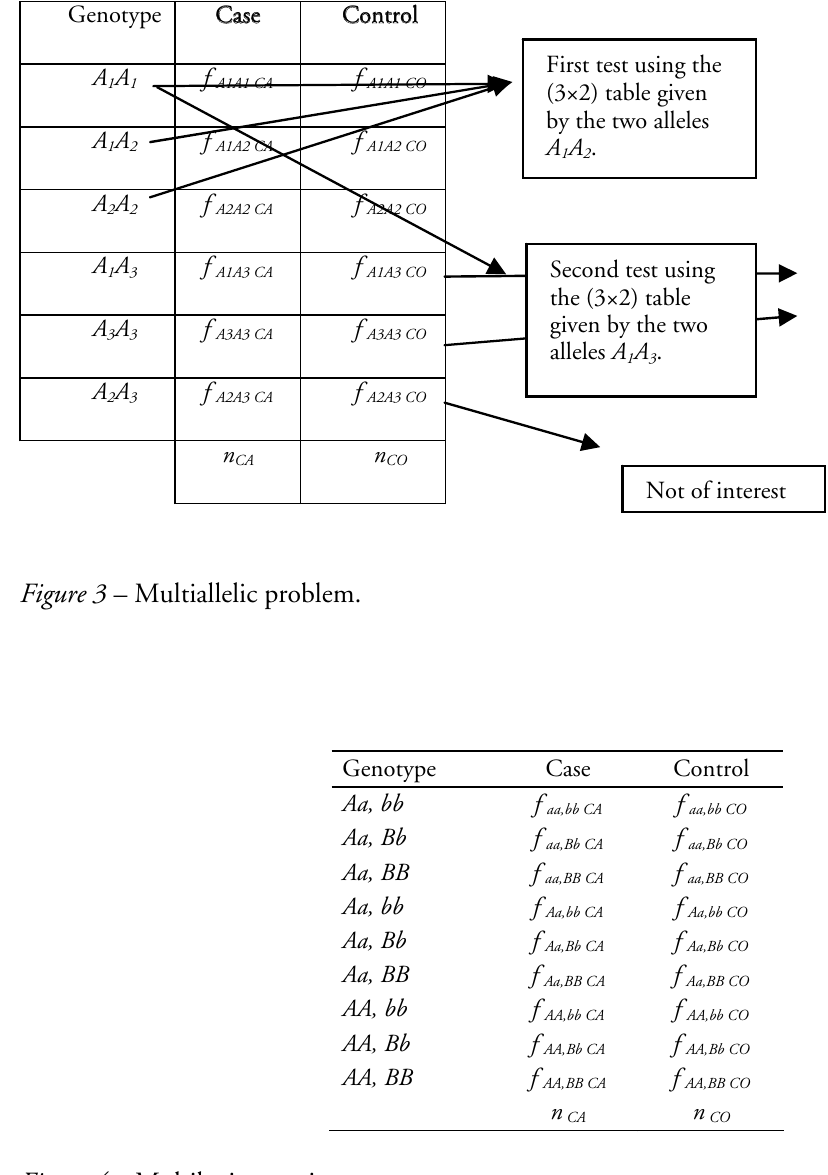
Figure 4 – Multiloci